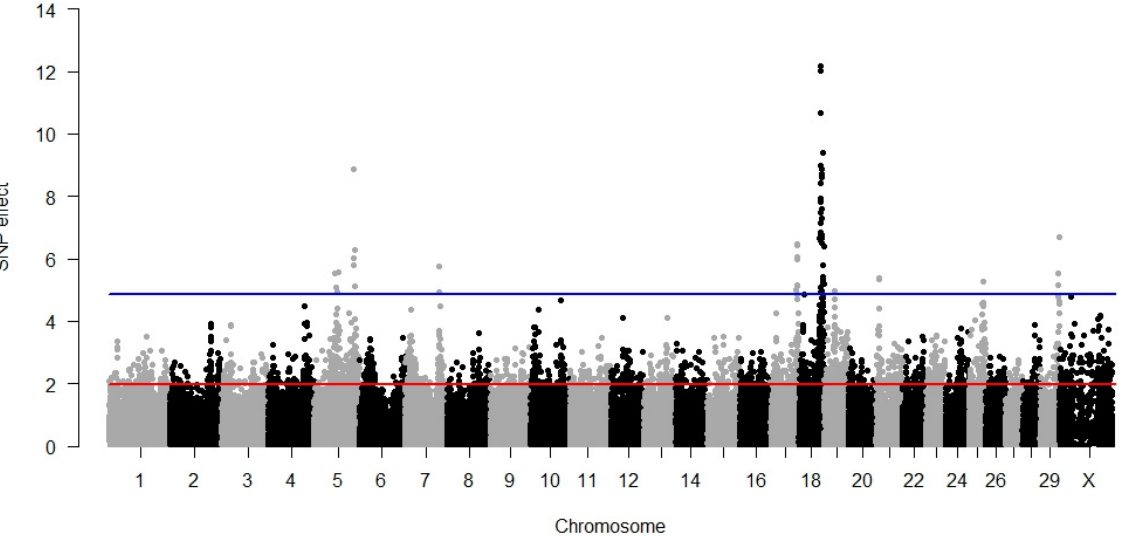
Figure 1. GWAS results for direct calving ease. The red line (1.96) represents a nominal and the blue line (4.88) a Bonferroni-corrected critical value corresponding with a 5% significance level. By moving the scope from the genes to the functions classified through GO terms, we identified seven significant biological processes: cartilage condensation, cell aggregation, artery development, nucleus localisation, cardiac myofibril assembly, myofibril assembly,